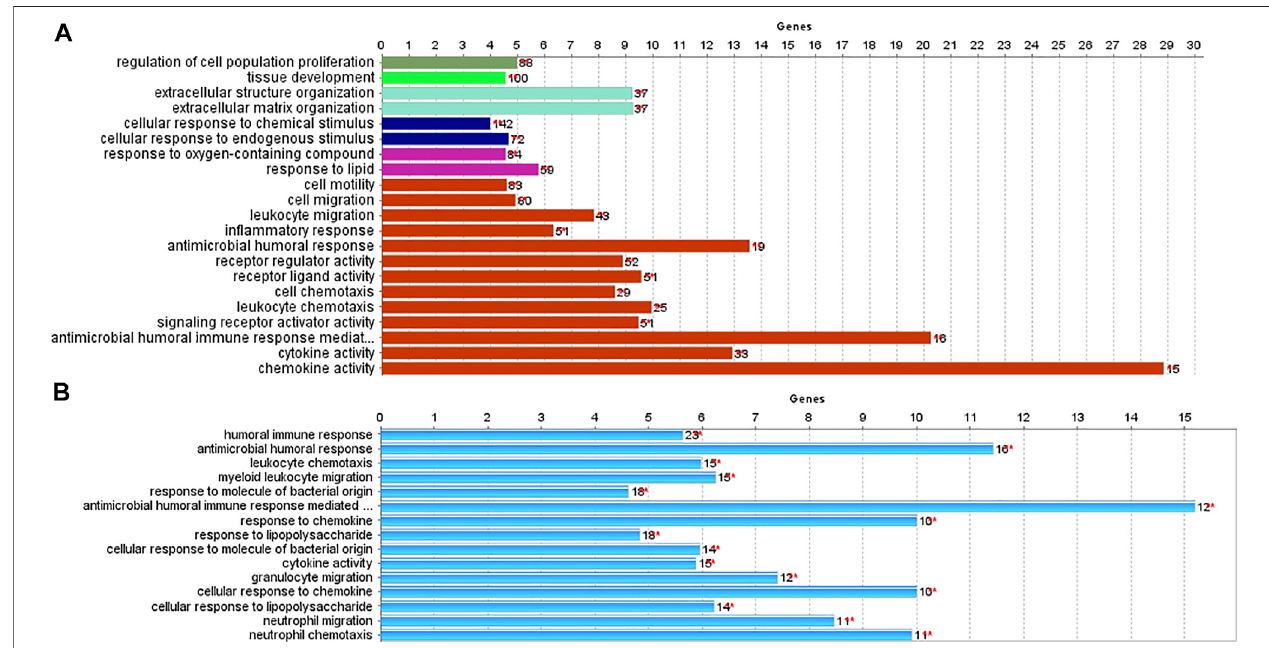
FIGURE 4 | Biological processes and pathways identi fi ed in CRC and IBD using their differentially expressed genes (DEGs). The analysis was performed using the ClueGO and CluePedia tools. [ (A) : CRC dataset GSE110224; (B) : IBD dataset